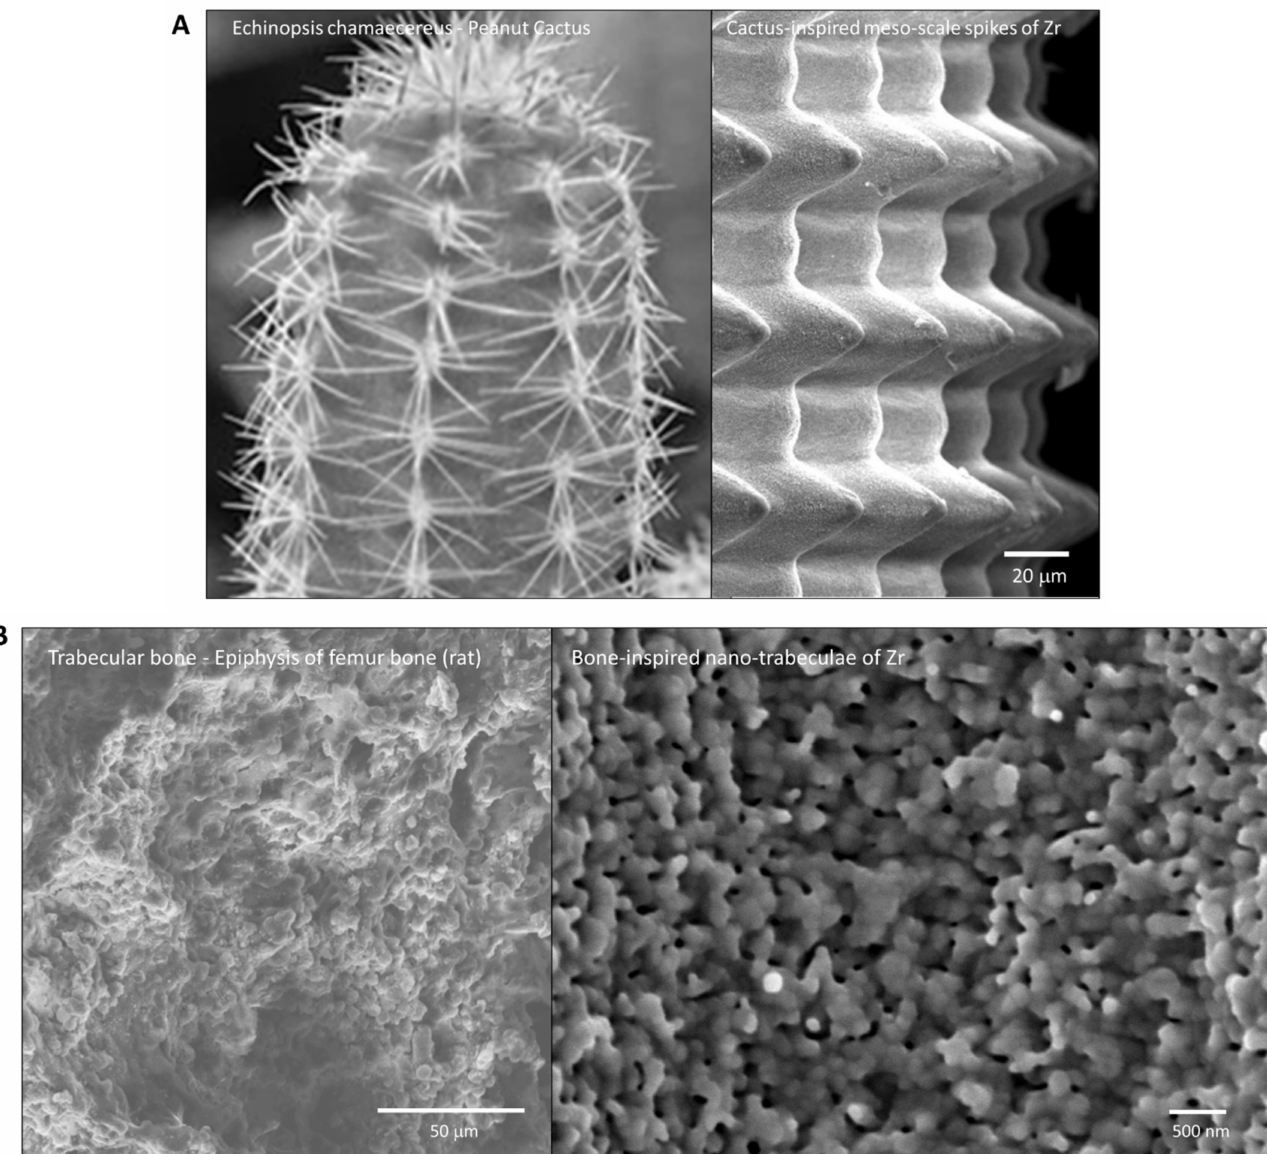
Figure 13. Biomimetic zirconia surface at dual meso- and nano-scale levels. ( A ) Cactus-inspired meso-scale spikes created by solid-state laser etching in the present study. Echinopsis chamaecereus peanut cactus (photograph) and the zirconia cylinder with 40 µ m-high spikes (SEM image) are presented. ( B ) Bone-inspired nano-scale trabeculae created by solid-state laser etching in the present study. Trabecular bone in the epiphysis of rat femur (SEM image) and the surface of a zirconia cylinder with 40 µ m-high spikes (high-magnification SEM image) are